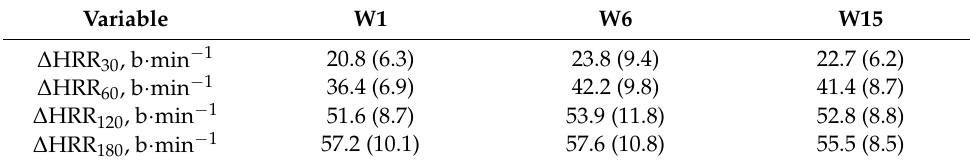
Table 3. Changes in HRR metrics during the firefighter recruit training academy, n = 25. Variable